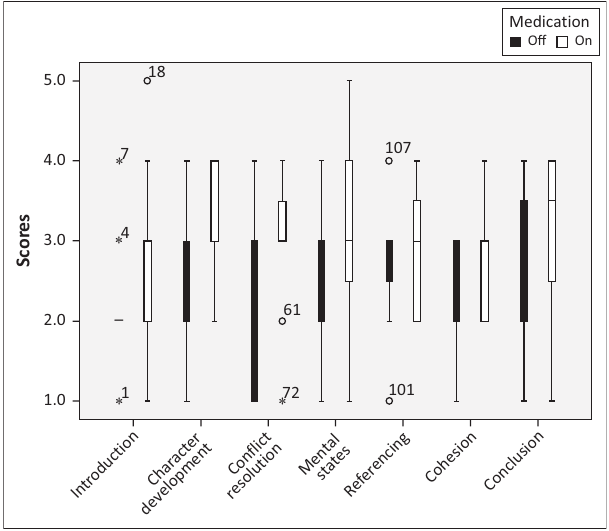
FIGURE 2: Boxplots indicating median and interquartile ranges for macrostructure elements, off and on